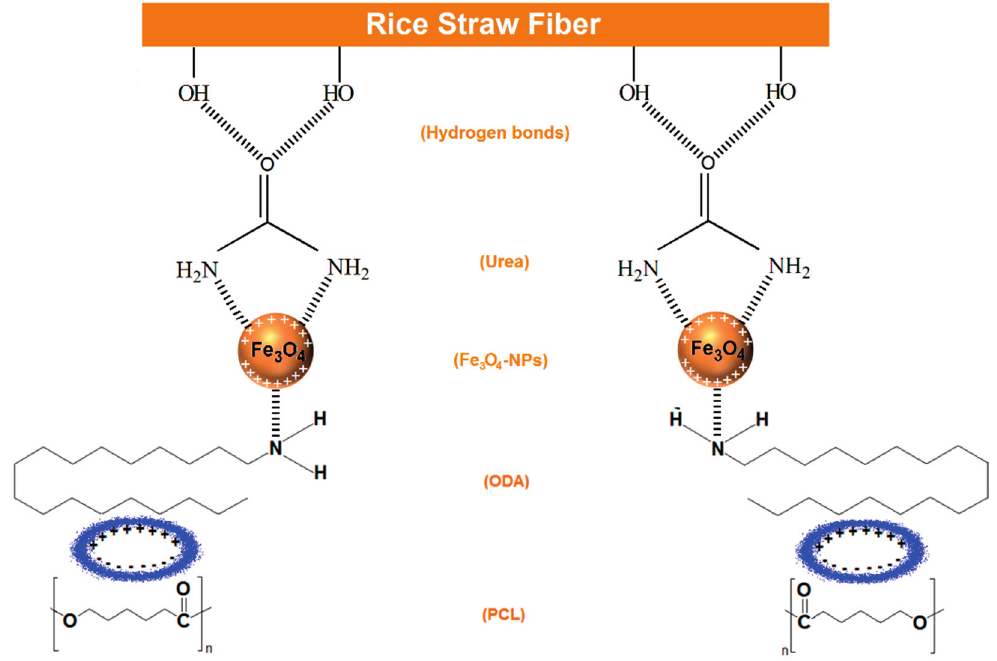
Figure 7. Schematic illustration of preparation of ORS/Fe 3 O 4